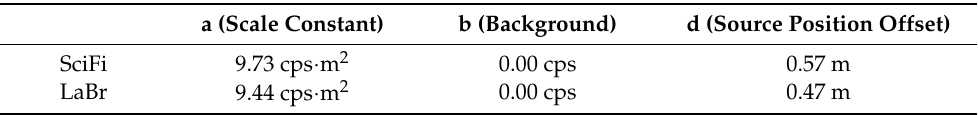
Table 3. Results of an inverse squared distance fit to the SciFi and LaBr count rates as a function of the distance from the source